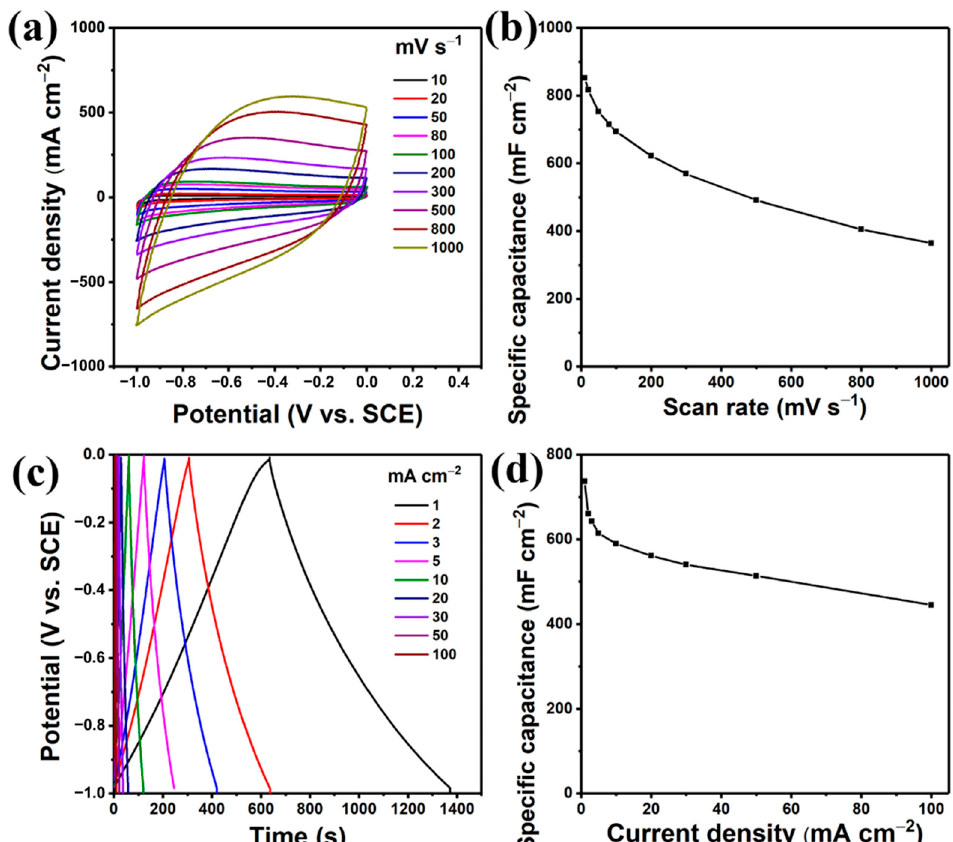
Figure 5. Electrochemical measurements of the CV and GCD curves using the three-electrode con- figuration: ( a ) CV curves of CNTs/NF electrode with different scan rates; ( b ) calculated areal specific capacitance values at different scan rates; ( c ) GCD curves of the CNTs/NF electrode with different current densities; ( d ) calculated areal specific capacitance values at different current densities.